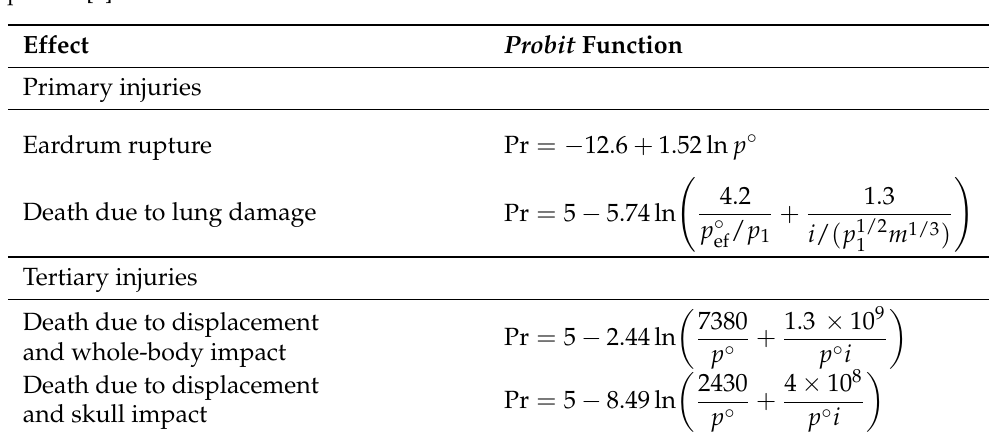
[Pa] the maximum effective ef